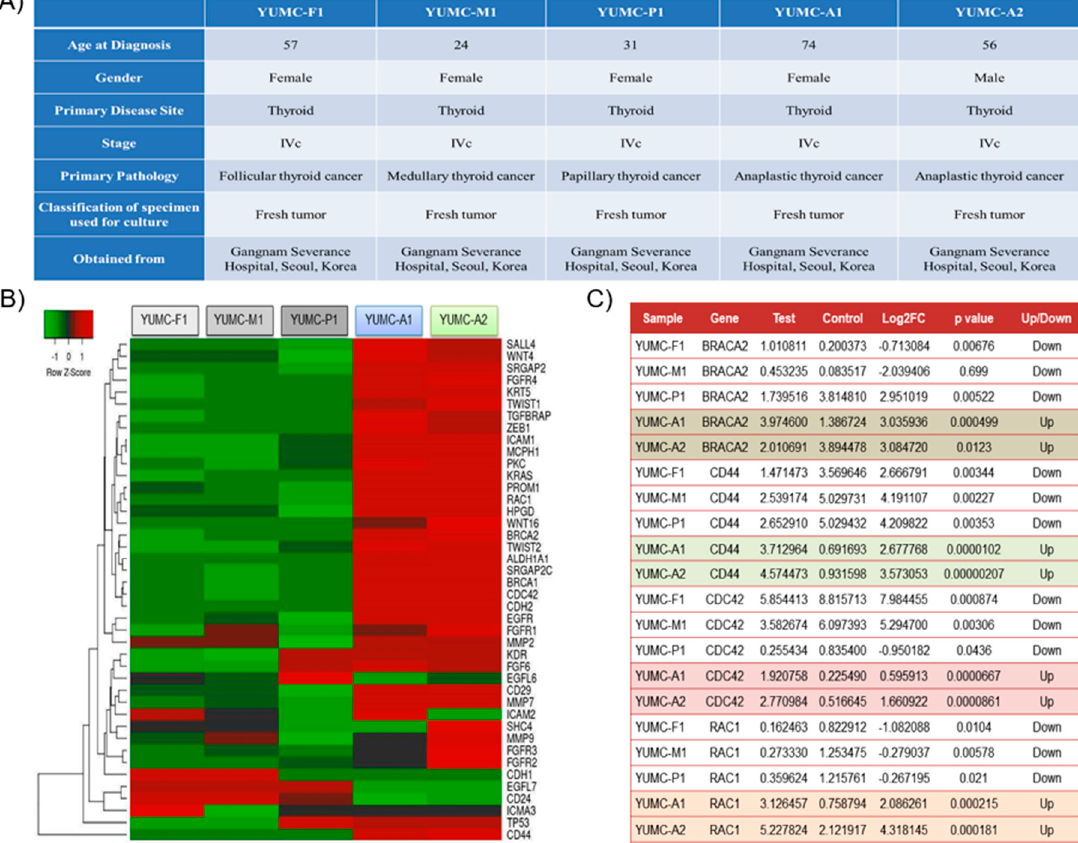
Figure 2. Characteristics of all thyroid cancer cell lines examined: ( A ) Characteristics of patient-derived subtypes of thyroid cancer cell lines, including viability after drug treatment of all thyroid cancer cell lines examined; ( B ) Hierarchical clustering of annotated genes revealed distinct gene expression. Gene expression profiles of various subtypes of patient-derived thyroid cancer cells; ( C ) The top four upregulated and downregulated differentially expressed genes (DEGs) for various subtypes of thyroid cancer cells.